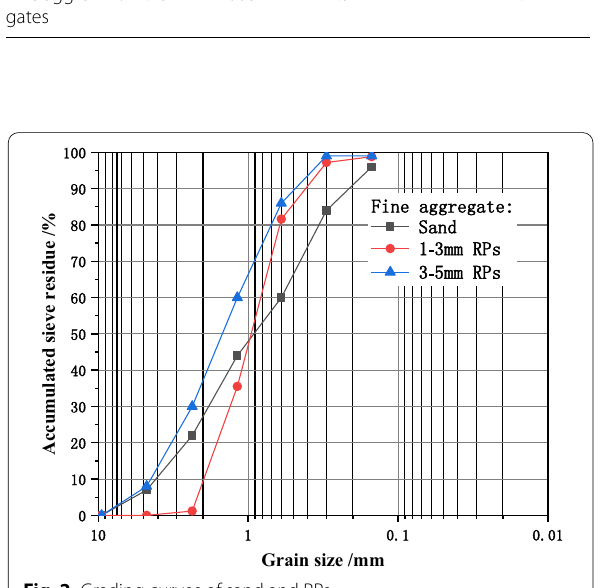
Fig. 2 Grading curves of sand and